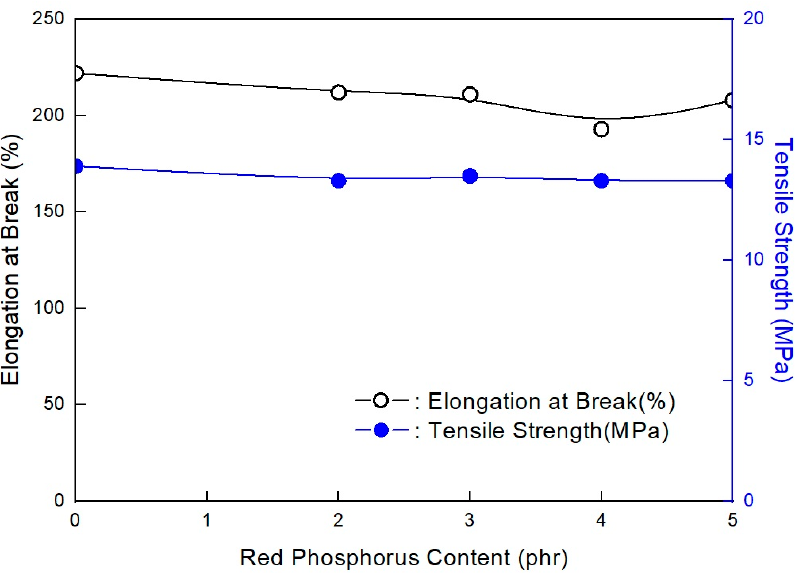
Figure 7. Mechanical properties of EVA/Tafmer DF805/CLNA-8400/EBM/120 phr flame-retardant (MH+ZB) formulations as a function of additional RP content.